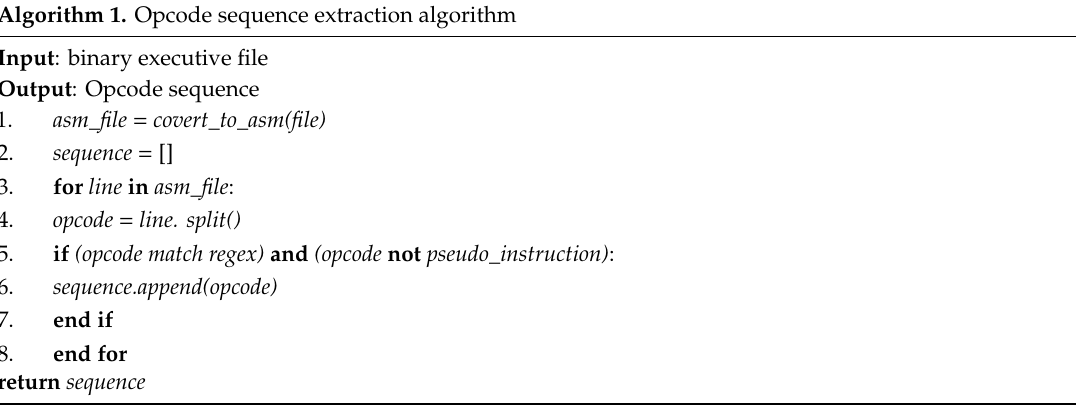
Algorithm 1. Opcode sequence extraction algorithm